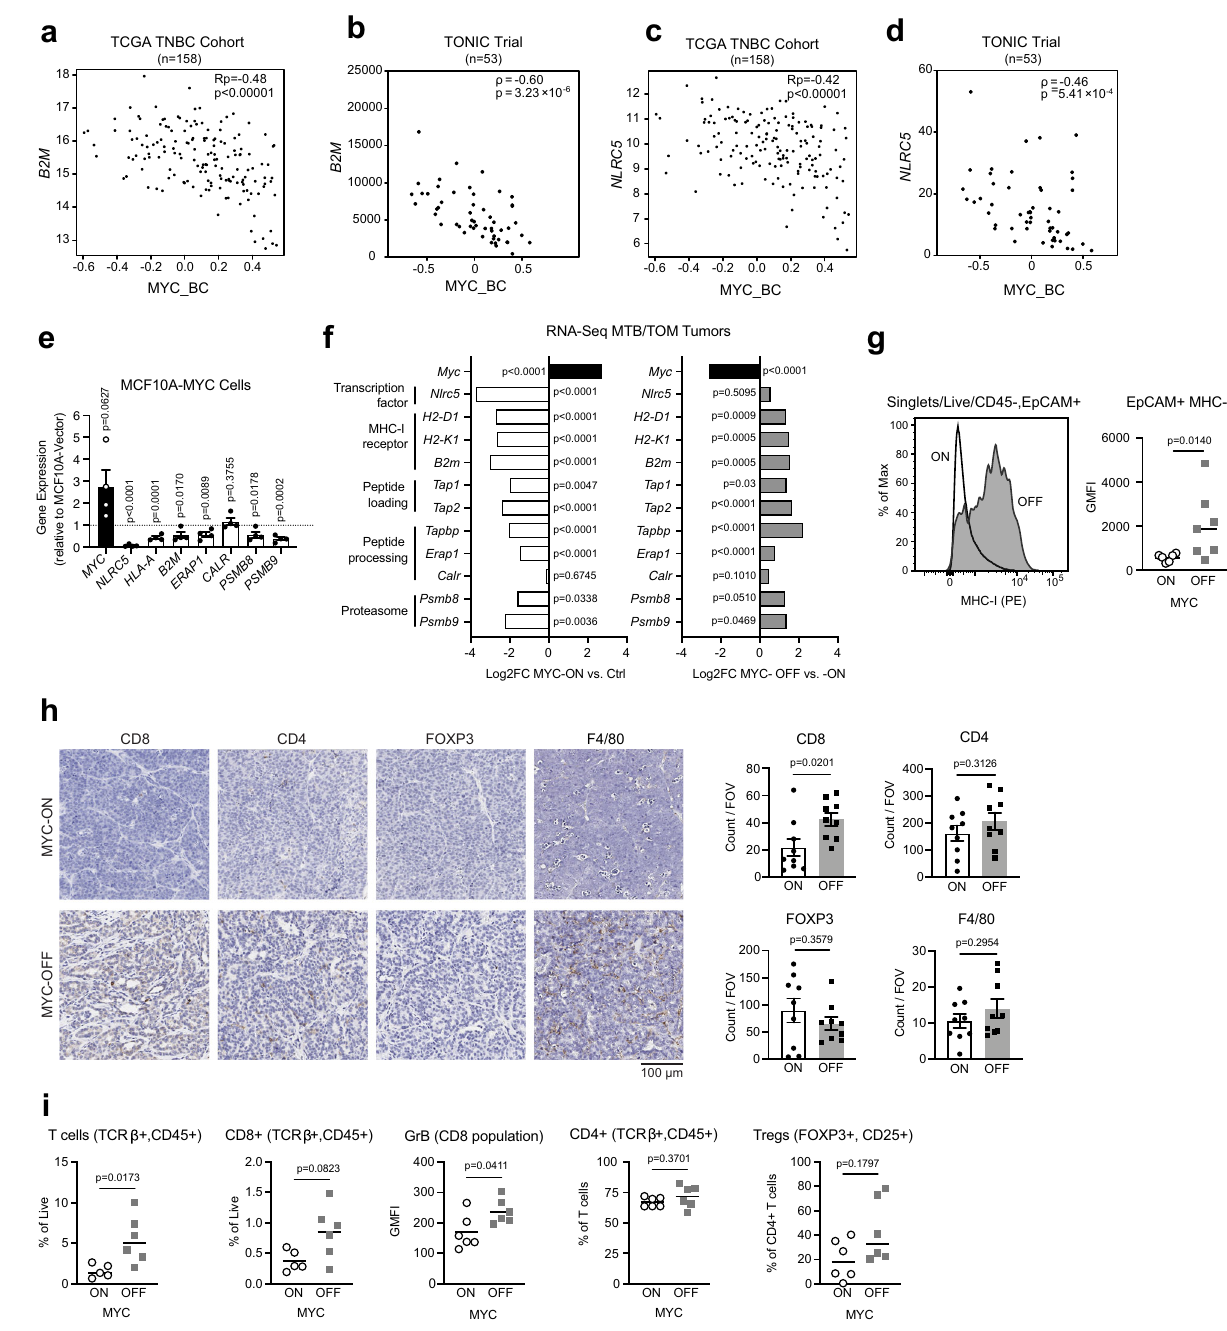
Fig. 2 MYC suppression of MHC-I expression is reversible. a – d Scatter plot correlation tested between the expression of ( a ) B2M gene and MYC_BC signature in TCGA TNBC patients, Pearson ’ s coef fi cient (Rp), adjusted p -value (Benjamini-Hochberg FDR corrected). b B2M and the MYC_BC signature in TONIC Trial patients, Spearman ’ s r ( ρ ), exact p -value. c NLRC5 gene and MYC_BC signature in TCGA TNBC patients, Pearson ’ s coef fi cient (Rp), adjusted p -value (Benjamini – Hochberg FDR for corrected). d NLRC5 gene and the MYC signature in the TONIC Trial patients, Spearman ’ s r ( ρ ), exact p -value. e Antigen presentation pathway genes in MCF10A-MYC cells compared to MCF10A-vector cells. Data displayed as fold change with values < 1 (dotted line) equating to gene repression. Displayed n = 4 independent cell passage replicates. Mean ± S.E.M, two-sided, unpaired t -test, exact p -values. f Differential expression analysis for RNA-seq data in MTB/TOM tumors published by Rohrberg et al. Left: MYC-ON compared to normal mammary tissue (Ctrl), Right: 3 days off-doxycycline (MYC-OFF) compared to animals on doxycycline (MYC-ON). Adjusted p -values. g Representative histogram for MHC- I expression by fl ow cytometry in MYC-ON and MYC-OFF states. Adjacent bar graph displaying geometric mean fl uorescence intensity (GMFI) for MHC-I in MYC-ON ( n = 6) and MYC-OFF ( n = 7). Line represents median, data points represent individual animals, two-sided, Mann – Whitney test, exact p -value. h Immunohistochemistry staining of immune cell markers within tumor sections in MYC-ON and MYC-OFF state. Images are at 20X. Adjacent bar graphs displaying cumulative counts per fi eld of view (FOV). n = 3 animals per group, 3 FOV analyzed per tumor, mean ± S.E.M. two-sided unpaired t -test, exact p - values. i Flow cytometry analysis of immune cells found in MYC-ON tumors or MYC-OFF tumors (off doxycycline chow for 3 days) ( n = 6 per group). Line represents median, data points are individual animals, outliers removed, two-sided Mann – Whitney test, exact p -values. Source data are provided in the Source Data fi le. Source data for panels b and d provided at EGA (EGAS00001003535). NATURE COMMUNICATIONS|